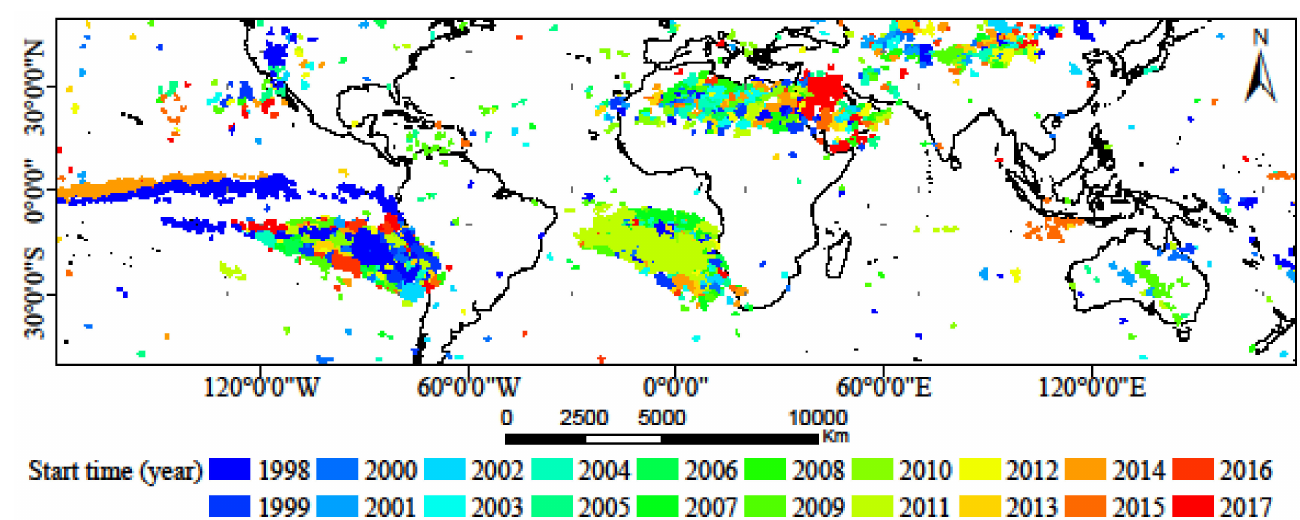
Figure 5. Start time of the breakpoints in the pixel-based global precipitation time series (1998–2019).